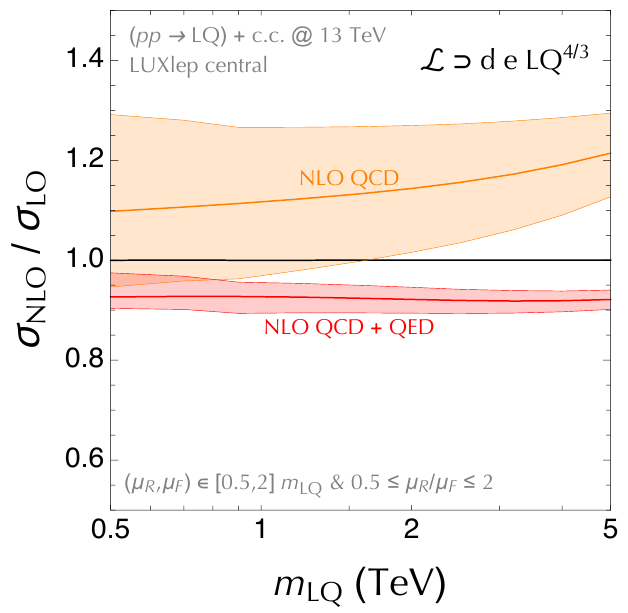
Figure 3 . NLO K -factor ( σ NLO /σ LO ) for the resonant scalar leptoquark production at 13 TeV LHC. Shown with orange (red) solid lines are the NLO QCD (NLO QCD + QED) predictions normalised to the LO when setting the central scales to µ R = µ F = m LQ . The colored bands are obtained by varying factorisation and renormalisation scales in the NLO calculations within { µ F , µ R } ∈ [0 . 5 , 2] m LQ while respecting 1 / 2 ≤ µ R /µ F ≤ 2 . We use the central PDF set from LUXlep-NNPDF31_nlo_as_0118_luxqed (v2) [47]. The benchmark example in the plot is a lepto- quark with | Q LQ | = 4 / 3 coupled to the down quark and electron. All other cases are shown